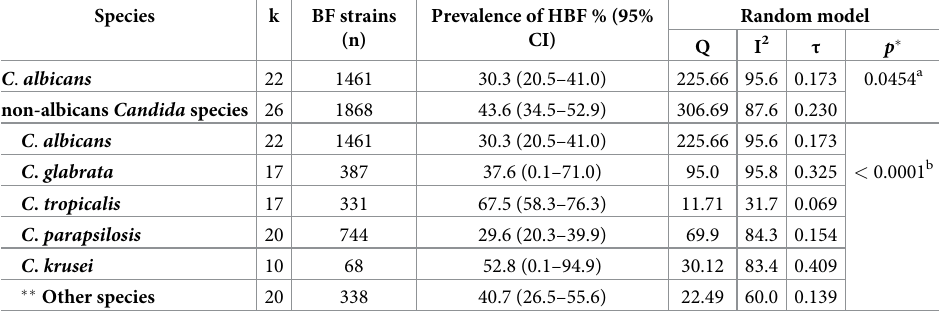
Table 6. Subgroup analysis between different Candida